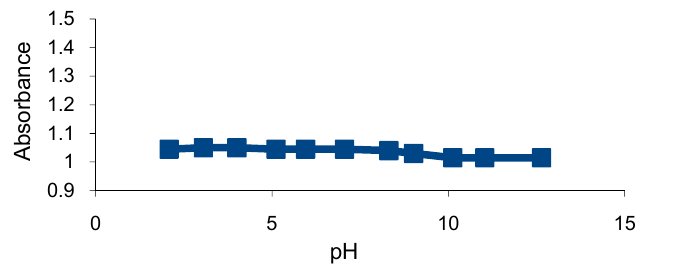
Figure 2. Turbidity absorbance of sensing element for 0.001 M Hg 2+ at different